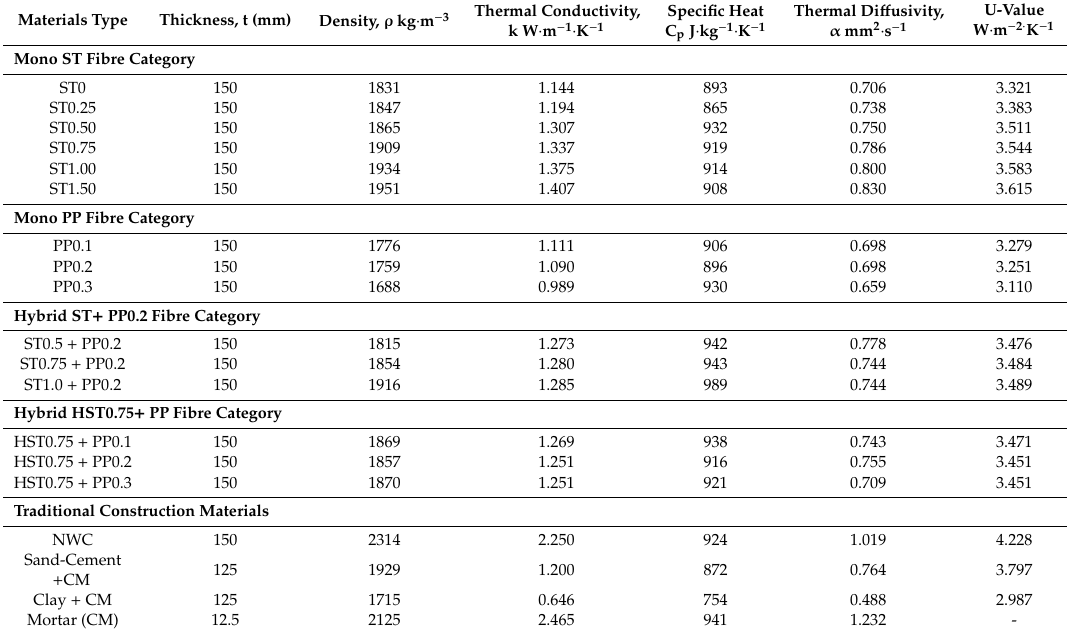
Table 2. Physical and thermal properties of the fibre-reinforced LECA-LWAC, normal weight concrete (NWC) and bricks and mortar based on experimental data.